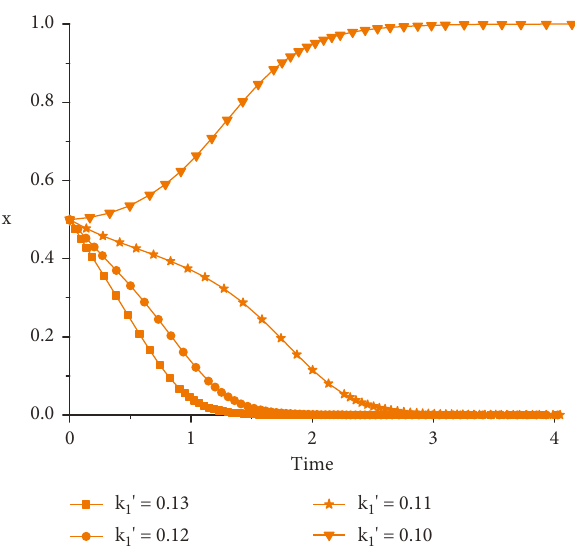
Figure 11: Impact of subjective portion coefficient b 2.